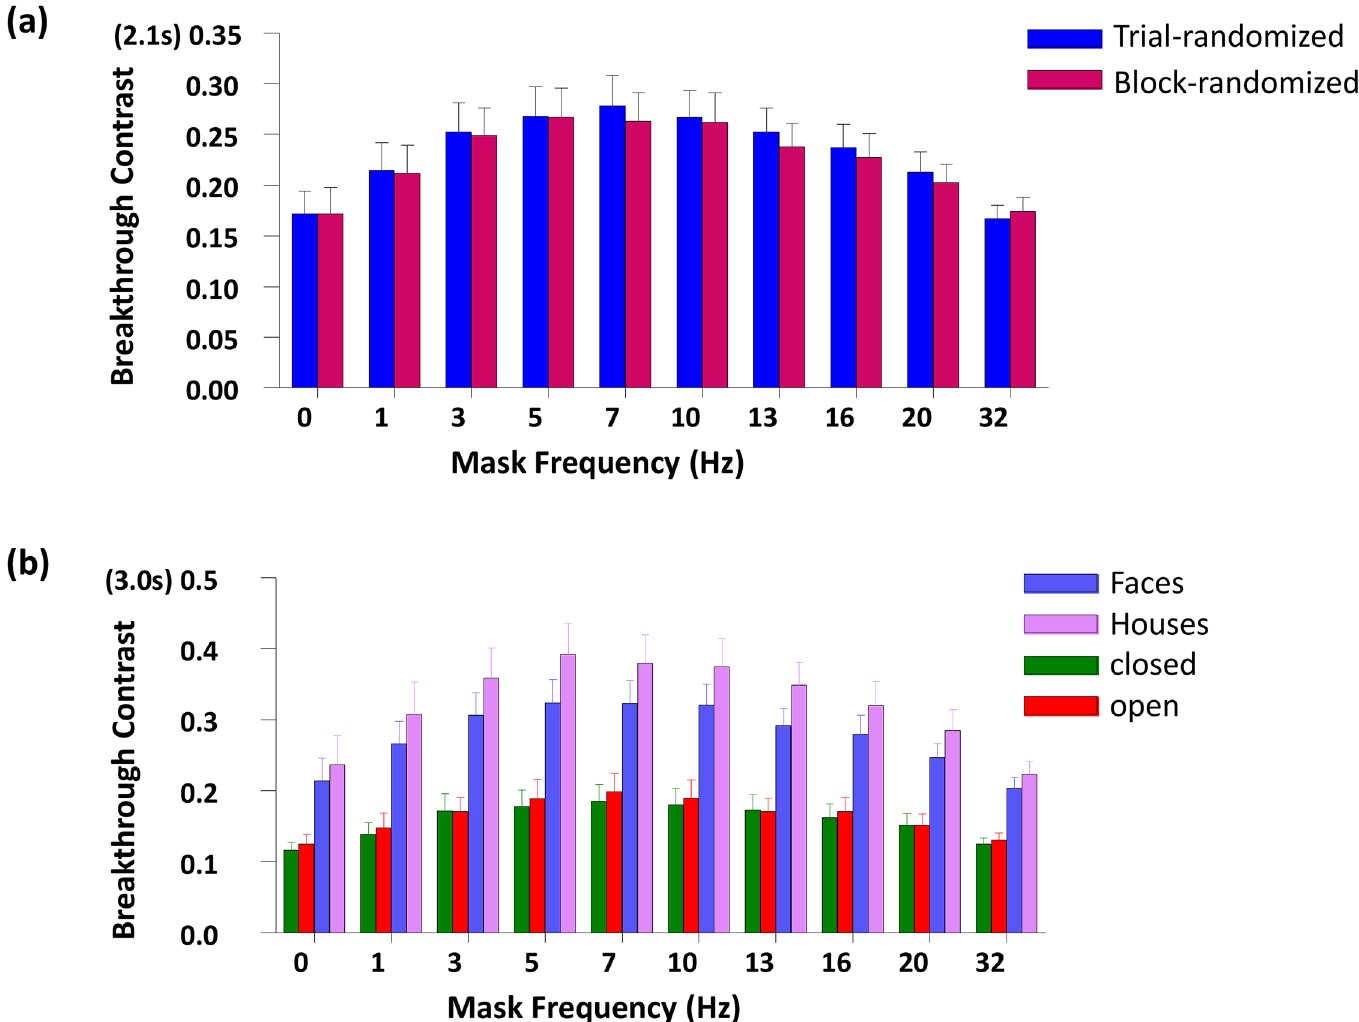
Fig 3. Breakthrough contrasts over ten frequencies. (a) for the two randomization conditions. (b) for the four stimulus